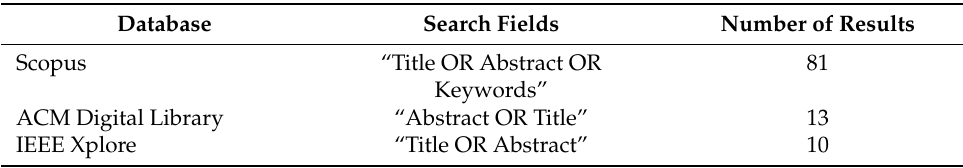
Table 4. Search field per